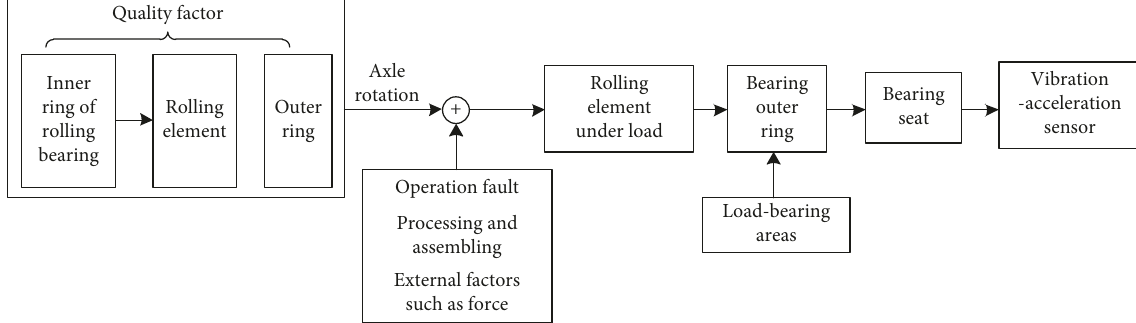
Figure 3: Transfer path of the pickup vibration signal by the acceleration sensor.